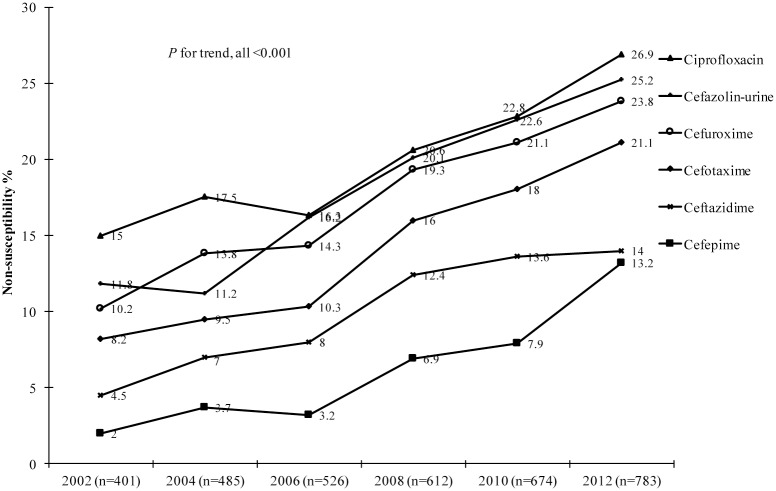
Increasing non-susceptibility (%) of E. coli to different agents from community setting, Taiwan, 2002–2012.